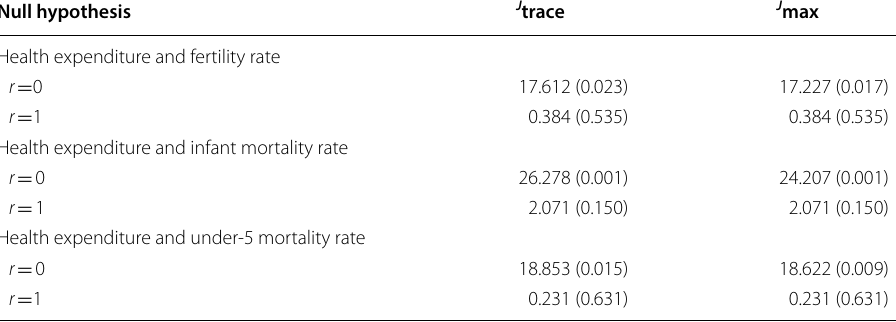
p value is in the